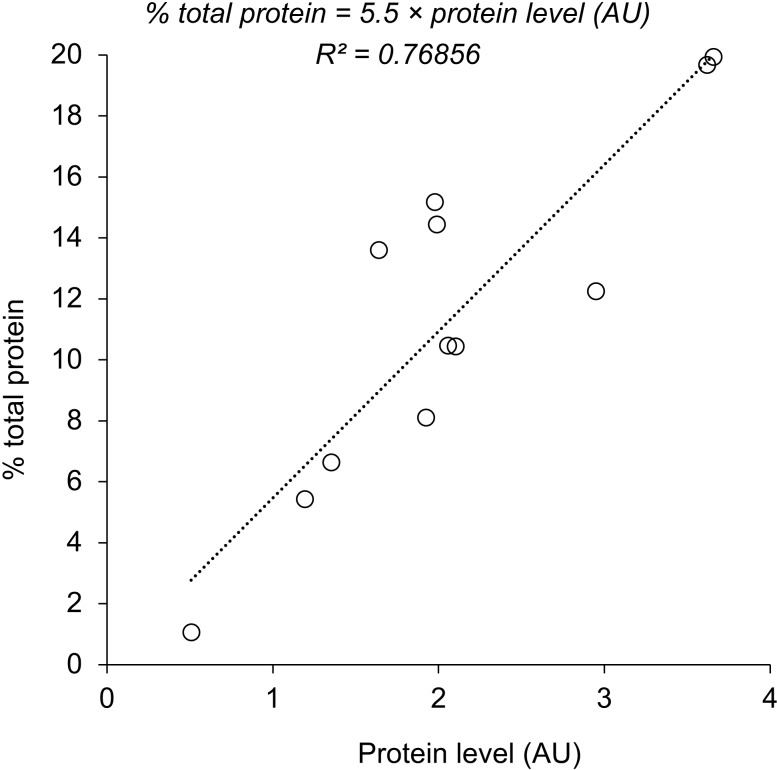
Relationship between percentage of total protein in (Kintaka et al., 2016) and protein level (AU) in this study.The equation derived by the linear regression of the data and the R-squared value are shown. Each circle indicates an independent measurement from Gpm1 (six samples), Pgk1 (three samples), and Adh4 (four samples) experiments.